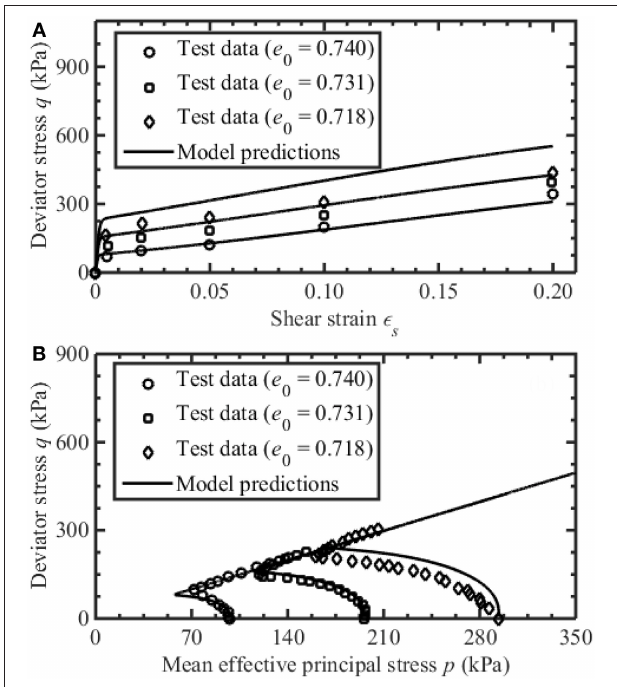
FIGURE 1 | Model prediction of the undrained monotonic behavior of Fuji River sand ( Ishihara et al., 1975): (A) deviator stress vs. shear strain, (B) deviator stress vs. mean effective principal stress.